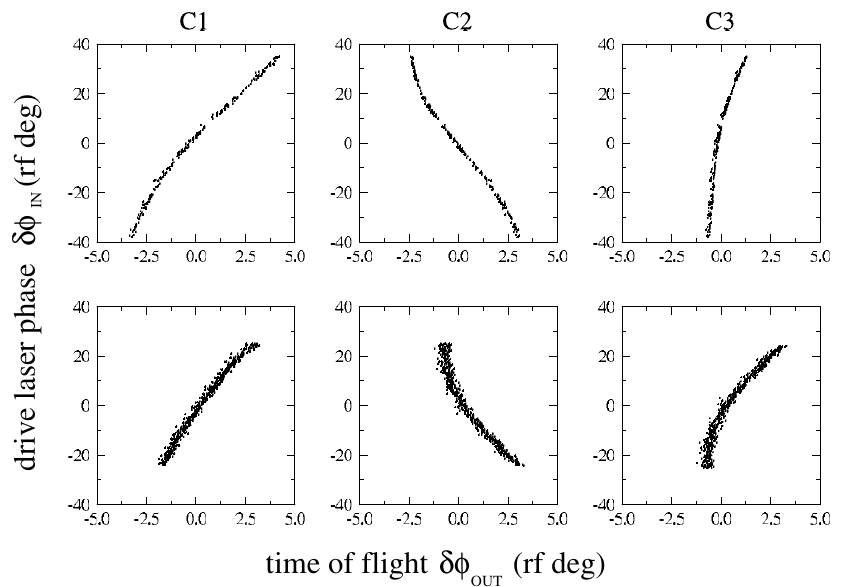
FIG. 8. Comparison of the phase-phase beam transfer function between the photocathode surface and the three different pickup cavities (pickup C1, C2, and C3) (bottom row) with the one simulated using PARMELA (top